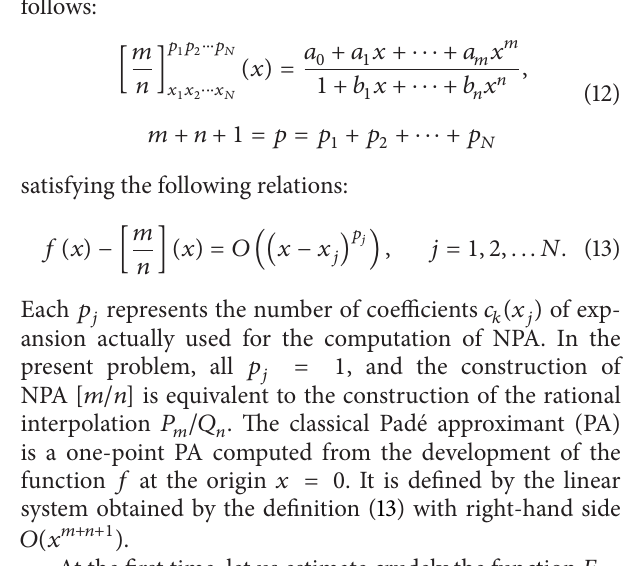
(ii) Teodorescu et al. 5-degree polynomial